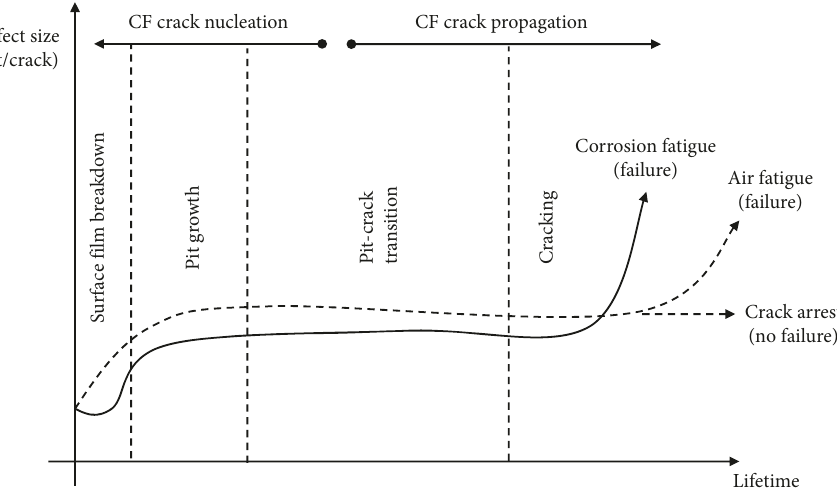
Figure 1: Schematic diagram of the CF damage evolution process [20].